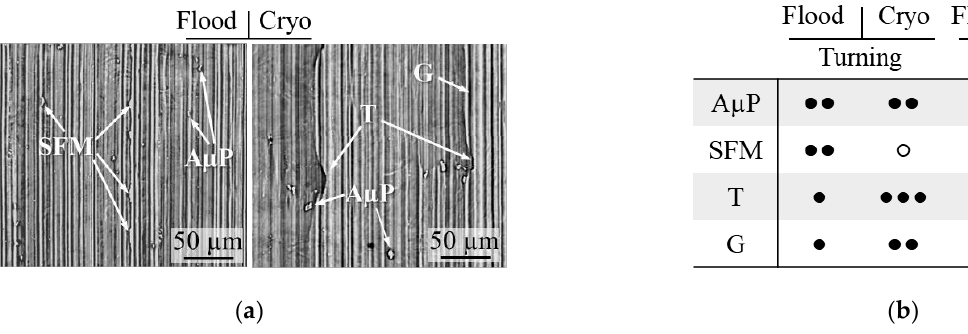
Figure 7. SEM images of the machined surface defects at varying cooling condition in case of cylindrical turning ( a ). The table ( b ) reports the summary of the defect entity charts (A µ PM: adhered microparticles; SFM: smeared feed marks; T: tearing; G: grooves).